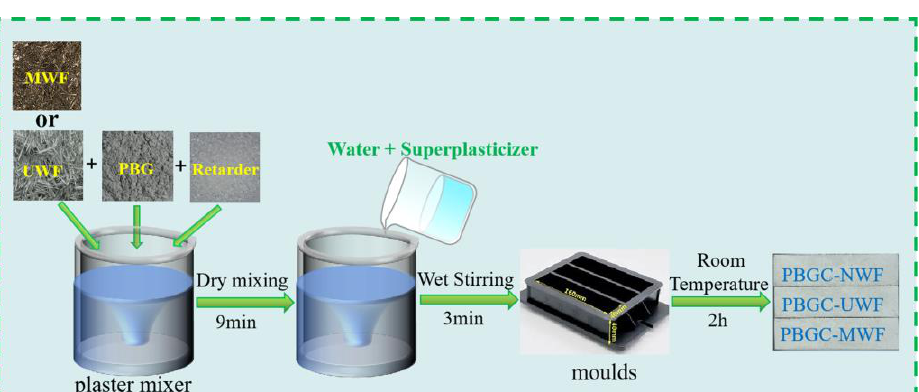
Figure 3. The flowchart of the PBGC preparation. Table 1. The chemical composition of PBG.